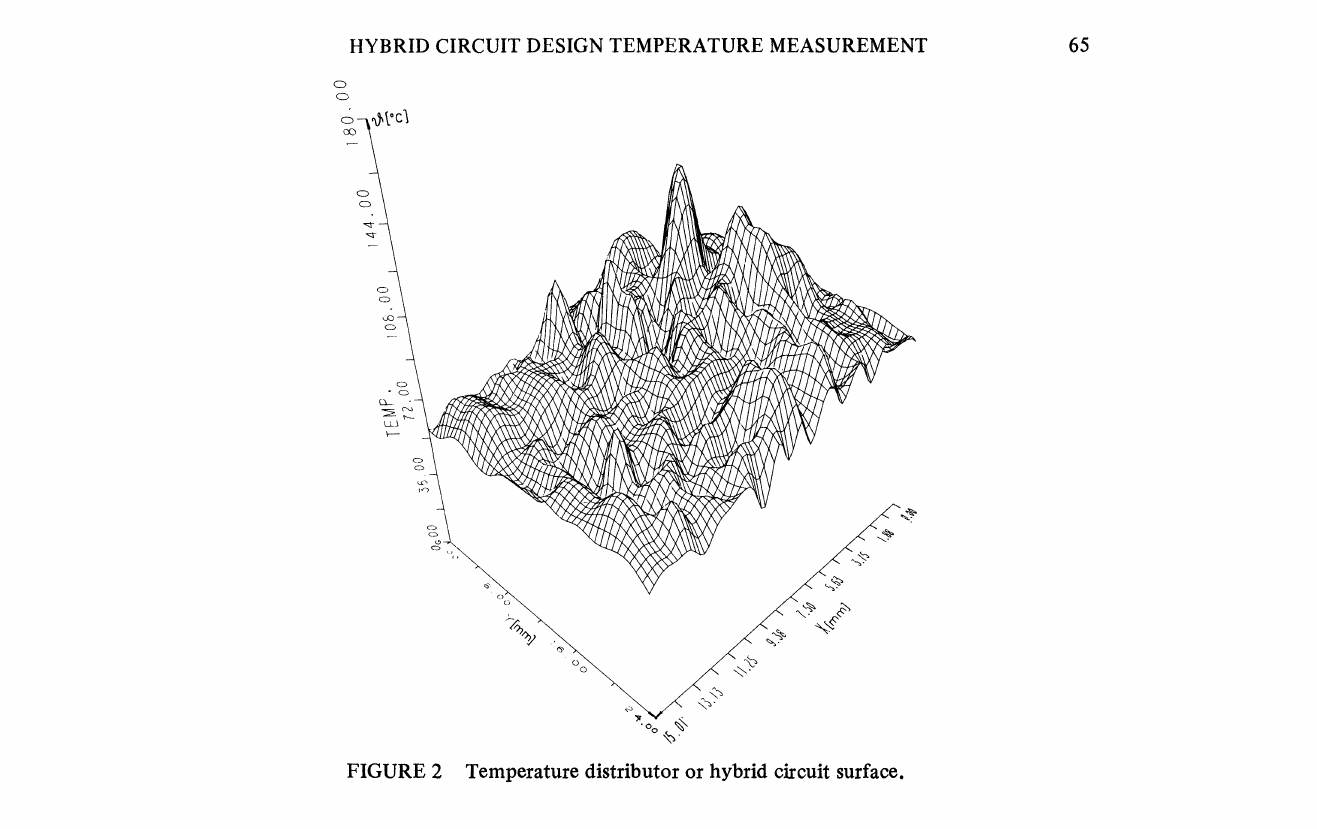
FIGURE 2 Temperature distributor or hybrid circuit